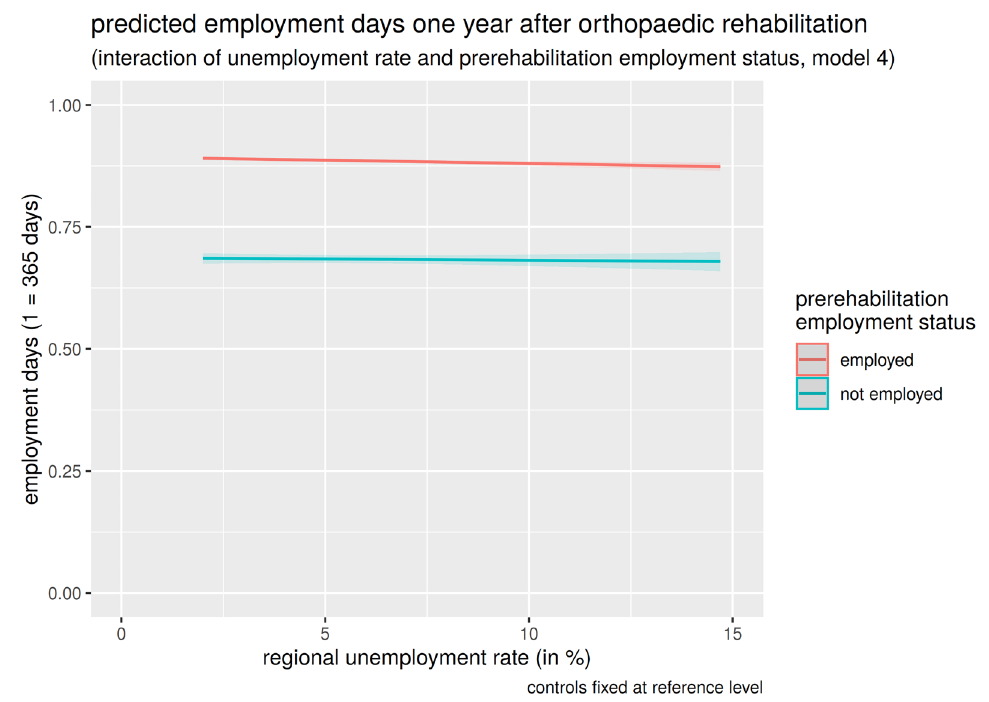
Fig. 3 Interaction of unemployment rate and prerehabilitation employment status in